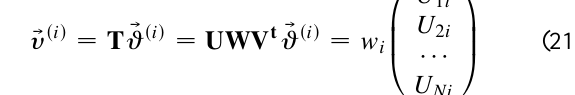
larger the response. Very small eigenvalues correspond to singular solutions where combinations of correctors lead to essentially no response on the measured orbit or dispersion.